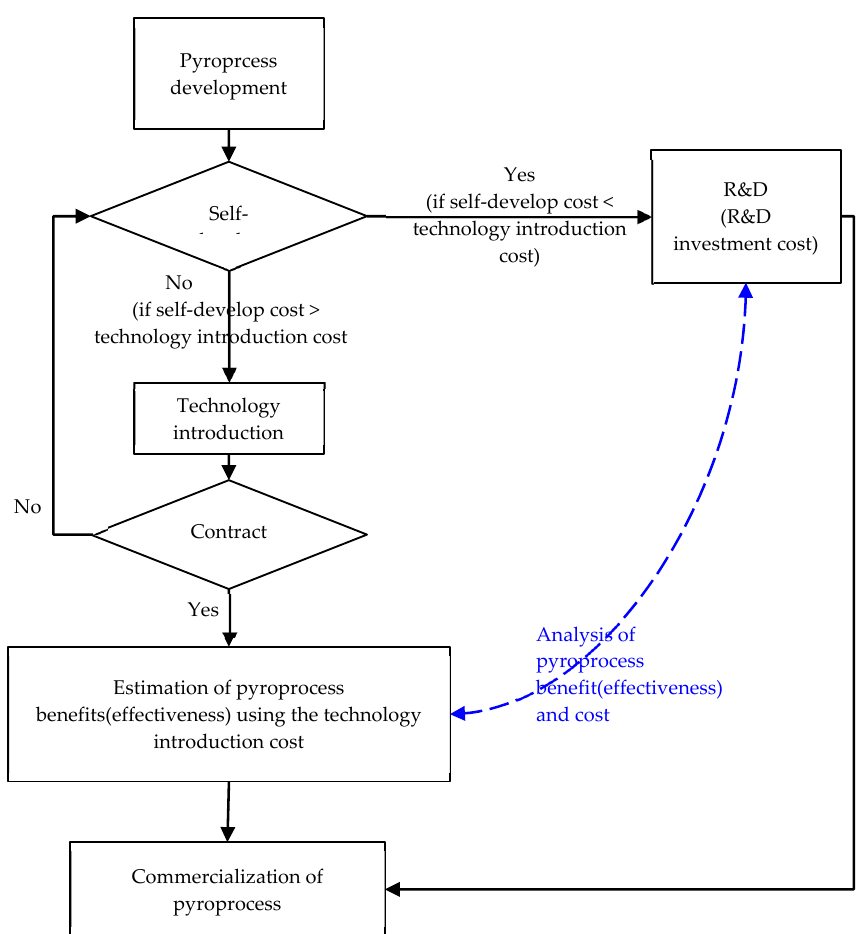
Figure 5. Analysis procedure of pyroprocessing